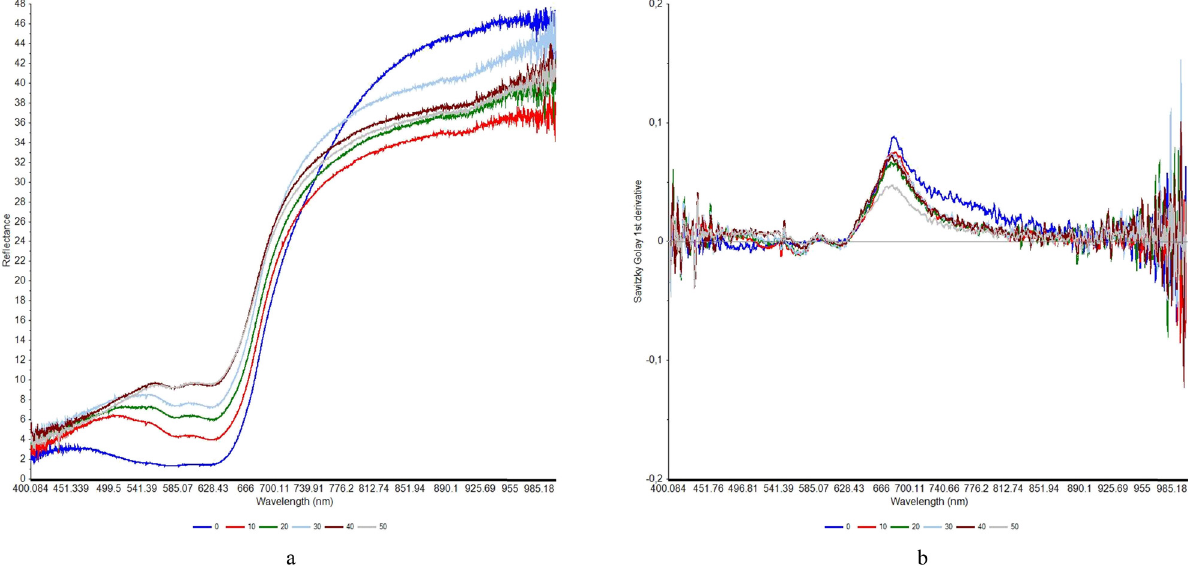
Figure 3: ( a ) Original ( insert ) and ( b ) Savitzky - Golay fi rst - derivative spectra of pure and SPI - added butter fl y - pea extract